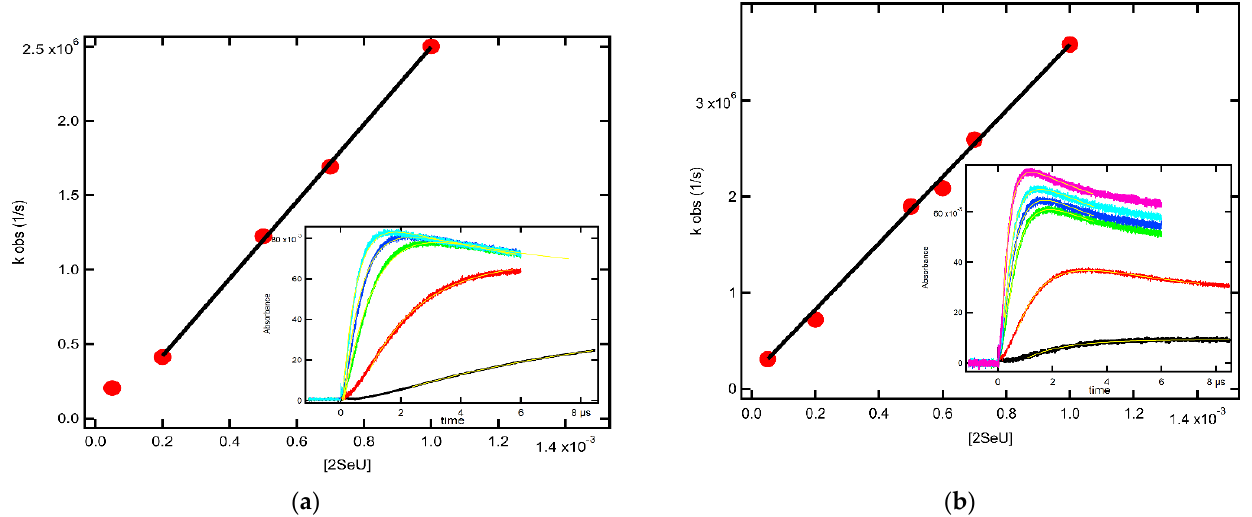
Figure 9. ( a ) Plots of the observed pseudo-first-order rate constants of the formation of the 440 nm absorption as a function of 2-SeU concentration in N 2 O-saturated unbuffered aqueous solutions at pH = 6 containing 30 mM NaN 3 . Inset: time profiles of transient absorption at λ = 440 nm at various concentration of 2-SeU: from the bottom, 0.05 mM ( − ), 0.2 mM ( − ), 0.5 mM ( − ), 0.7 mM ( − ), and 1 mM ( − ); ( b ) plots of the observed pseudo-first-order rate constants of the formation of the 440 nm absorption as a function of 2-SeU concentration in N 2 O-saturated unbuffered aqueous solutions at pH = 10 containing 30 mM NaN 3 . Inset: time profiles of transient absorption at λ = 440 nm at various concentration of 2-SeU: from the bottom 0.1 mM ( − ), 0.2 mM ( − ), 0.5 mM ( − ), 0.6 mM ( − ), 0.7 mM ( − ), and 1 mM ( − ).